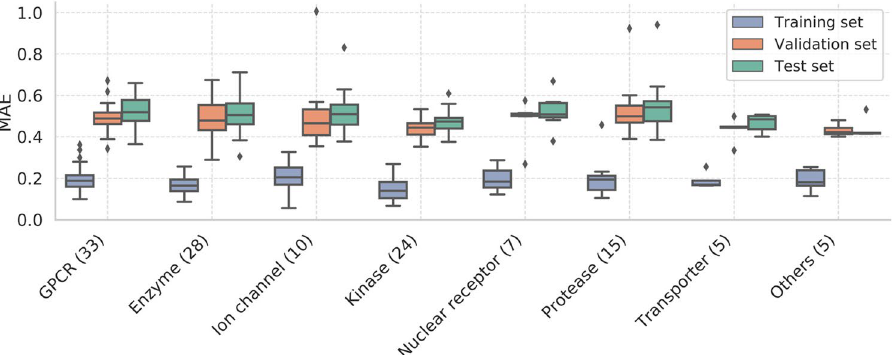
Figure 2. Box-whisker plots of the MAE of the ensemble models for each protein family. The horizontal lines in the boxes indicate the medians, the ends of the whiskers indicate the maximum and minimum MAE values, the bottoms and tops of the boxes are the 25th and 75th percentiles, and the points outside the whiskers are outliers. The number after each name on the x-axis shows the number of targets in each family. The same colour code for the data subsets is used throughout this